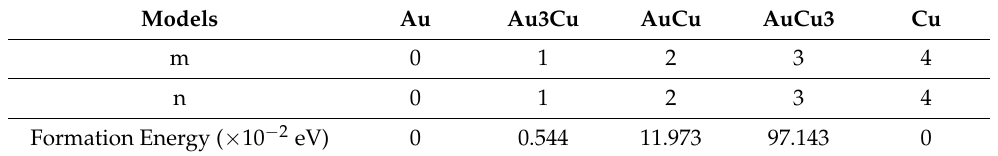
Table 2. m and n values for different models of Au-Cu alloys and their corresponding formation energies. Models Au Au3Cu AuCu AuCu3 Cu m 0 1 2 3 4 n 0 1 2 3 4 Formation Energy ( × 10 − 2 eV) 0 0.544 11.973 97.143